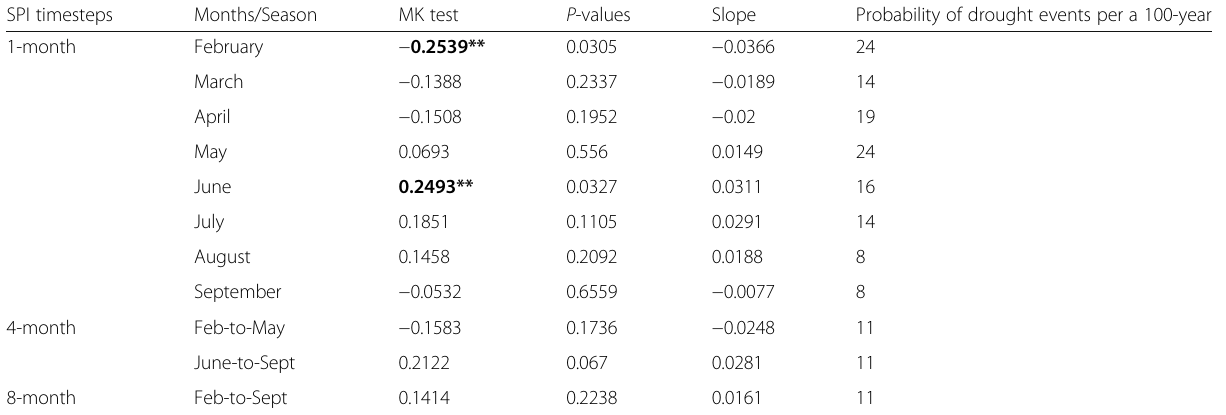
Table 3 Mann-Kendall ’ s trend analysis and the probability of drought events per 100-year for the rainy months and seasons at 1-, 4- and 8-months timesteps